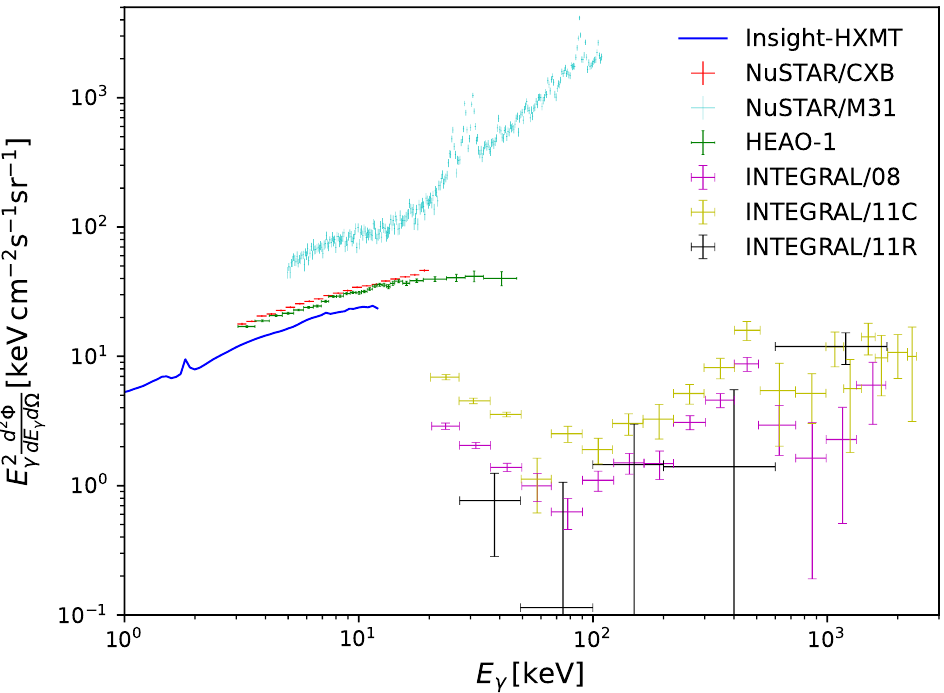
Figure 6 . The observed X(gamma)-ray fluxes by Insight-HXMT/CXB (blue) [149], NuSTAR/CMB (red) [150], NuSTAR/M31 (cyan) [151], HEOA-1 (green) [152], INTEGRAL (magenta, yellow, and black) [153, 154]. The three INTEGRAL data sets are released in 2008 (magenta) [153] and 2011 (yellow for 11C and black for 11R) [154] for different observational sky regions as described in the main